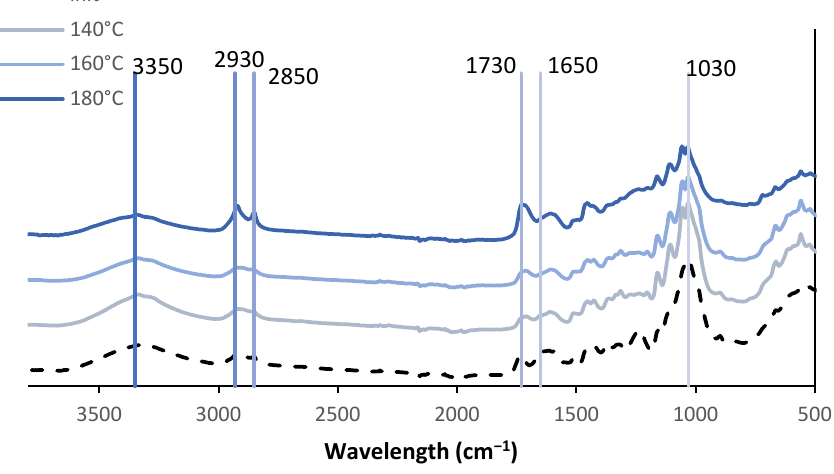
Figure 8. FTIR spectra of the initial material and of the solid residue obtained by liquefaction for 60 min at temperatures 140 °C, 160 °C and 180 °C with acid catalysis.